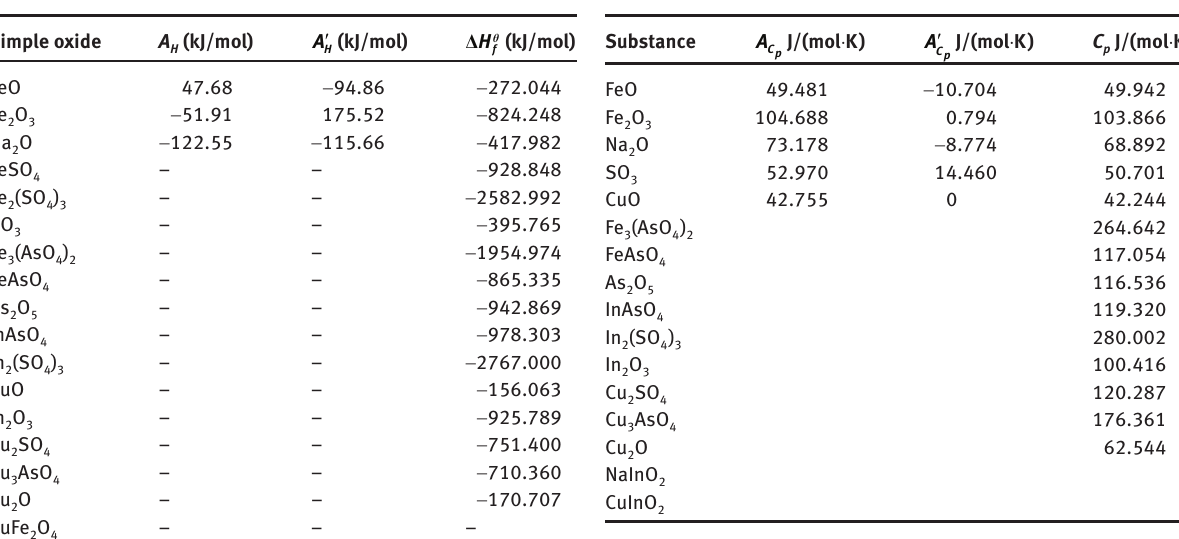
Table 1: A H , ′ H A and